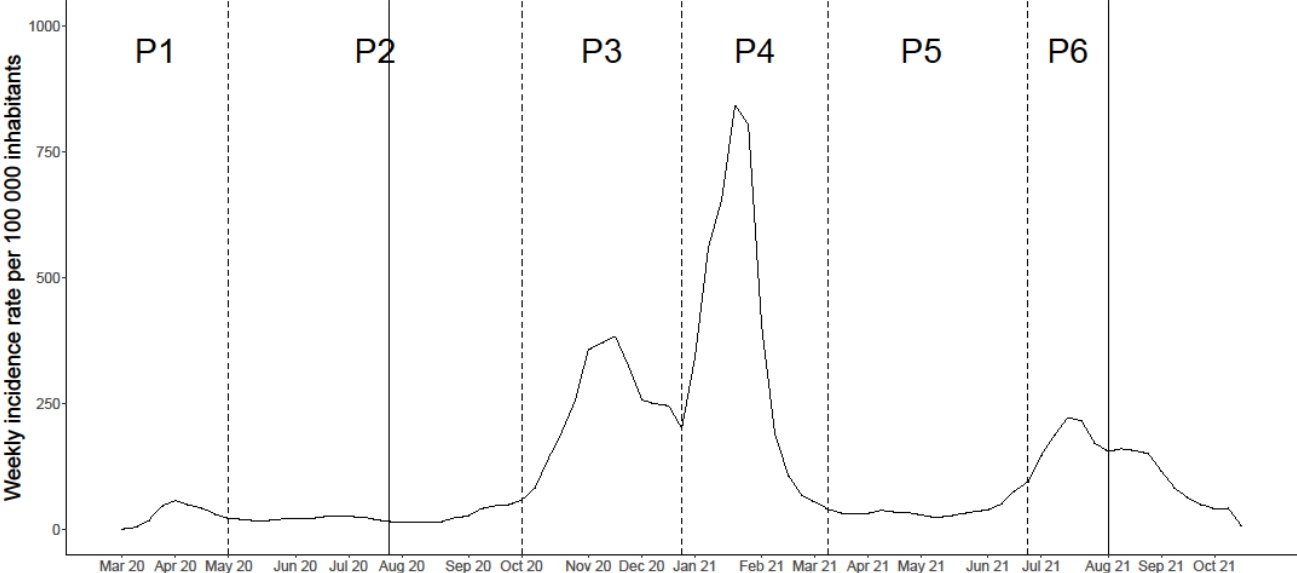
Figure 1. Weekly incidence rate of COVID-19 in Portugal. The solid vertical lines correspond to the beginning and end of the study period, while the dotted lines represent the defined epidemic waves and inter-wave periods. P—period of the pandemic.